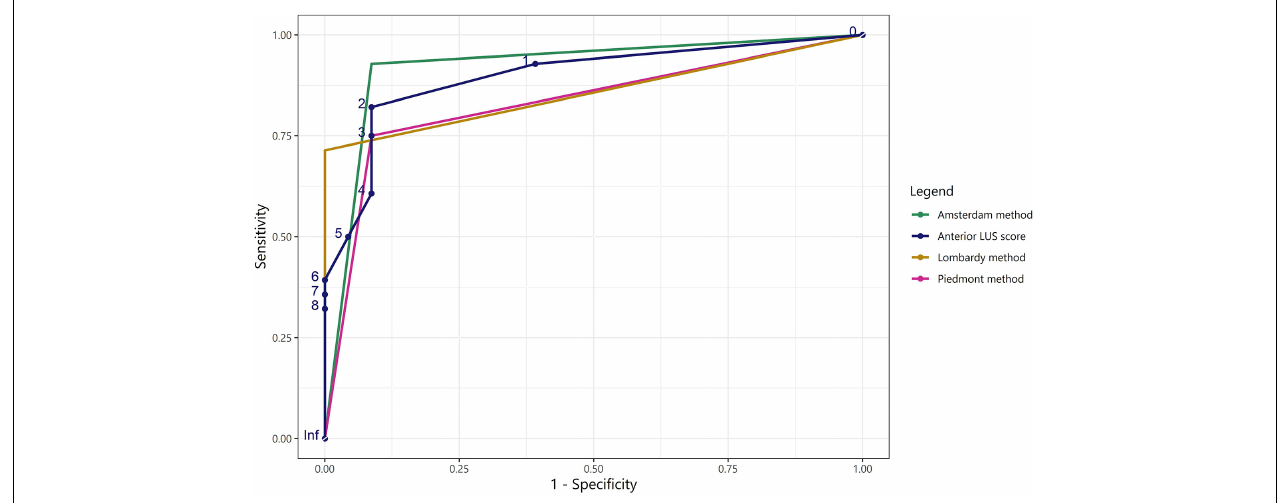
FIGURE 5 | Receiver operating characteristic curves for the LUS methods and the anterior LUS score in predicting non-focal lung morphology. ROC curves for the Piedmont, Amsterdam, and Lombardy method and for the anterior LUS score regarding classification of non-focal lung morphology when applied to both the Amsterdam and Lombardy cohort. The area under the ROC curve was: 0.83 for the Piedmont method, 0.92 for the Amsterdam method, 0.86 for the Lombardy method, and 0.90 for the anterior LUS score. As the output of the LUS methods for lung morphology classification is dichotomous, only one cut-off can be presented for the corresponding ROC curves. LUS, lung ultrasound; ROC, receiver operating characteristic.